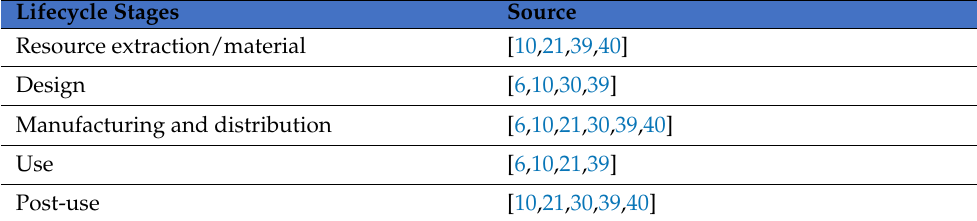
Table 3. Semantic integration of lifecycle stages (own